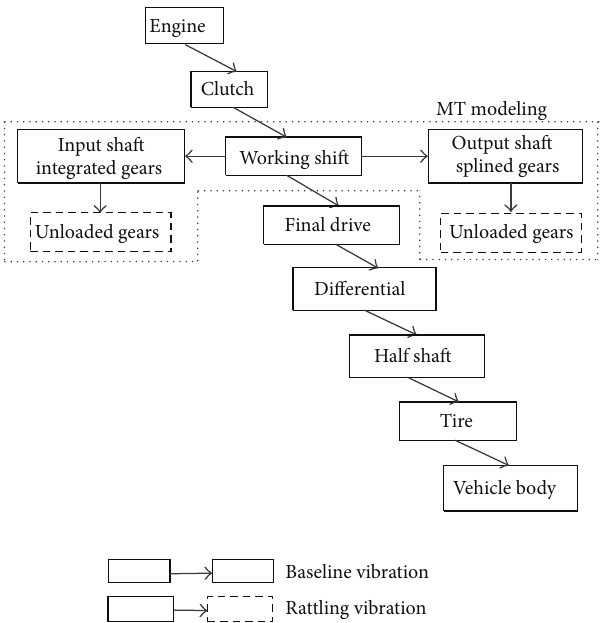
Figure 15: Modeling framework for driveline vibration and gear rattle